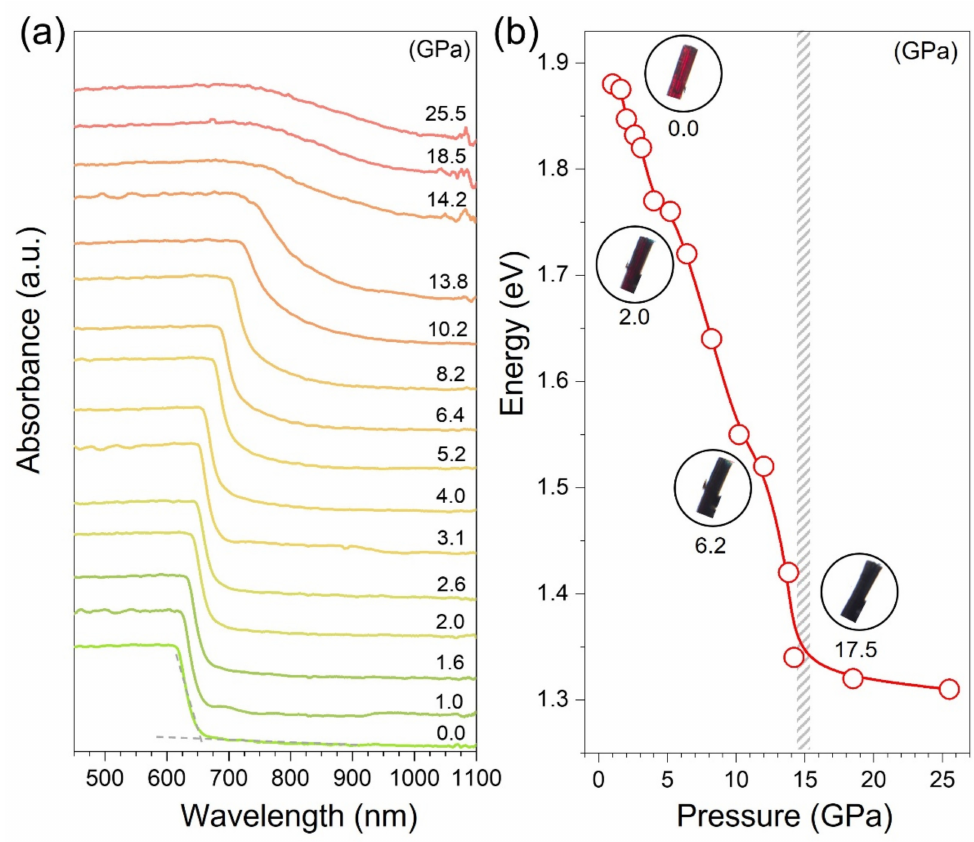
Figure 2. Optical absorption spectra of SbSI under pressure. ( a ) Optical absorption spectra of SbSI under pressure. ( b ) Pressure dependence of the bandgap energy for SbSI. Inset: optical micrographs of SbSI collected at different